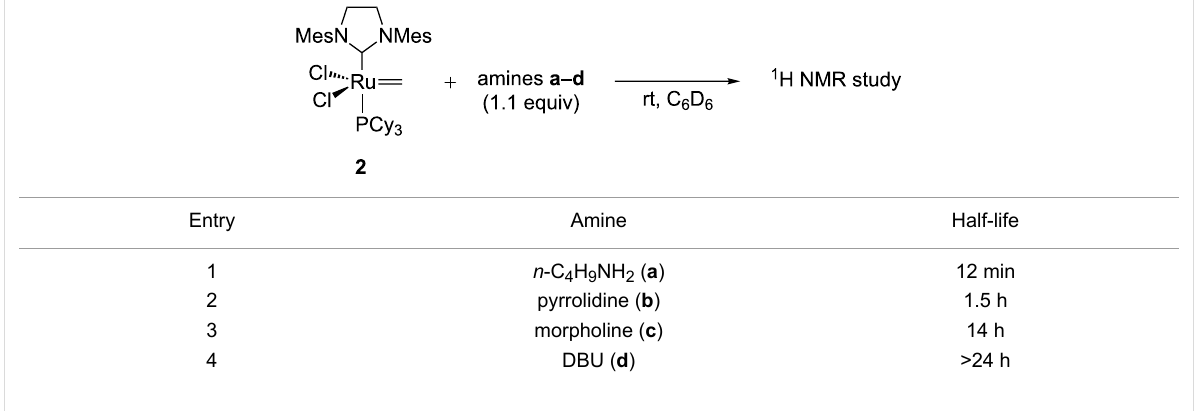
Scheme 4: Reaction of GII with amines a – d .